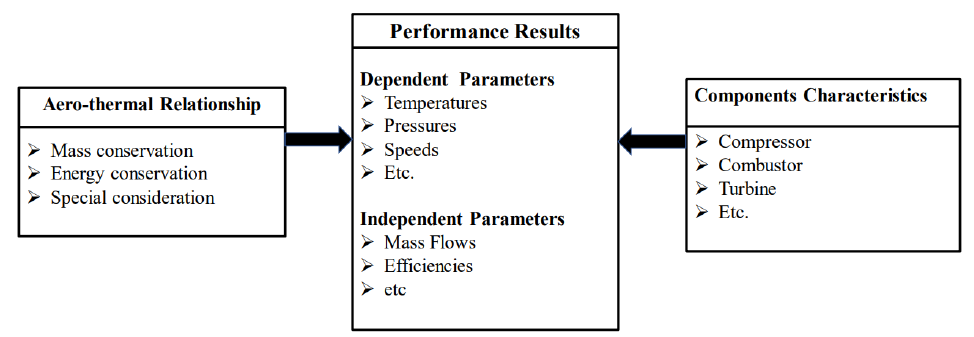
Figure 1. Gas Turbine Modelling Framework .